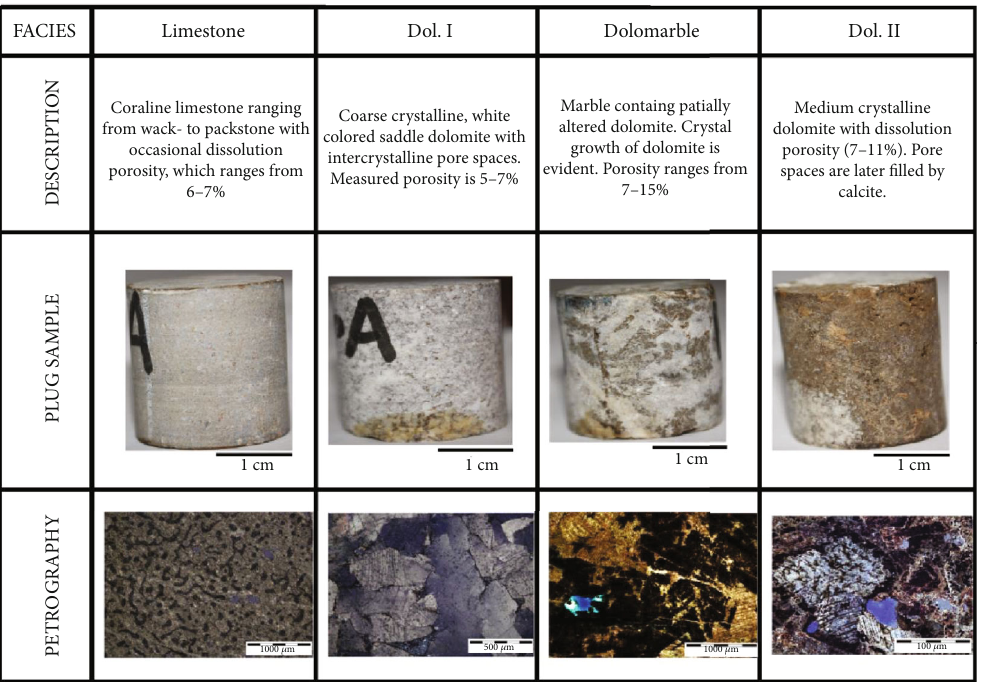
Figure 9: Illustration of selected facies and their correlation with the petrographic studies. It is observed that porosity and permeability values are related to speci fi c diagenetic facies (i.e., dolomarble and Dol.